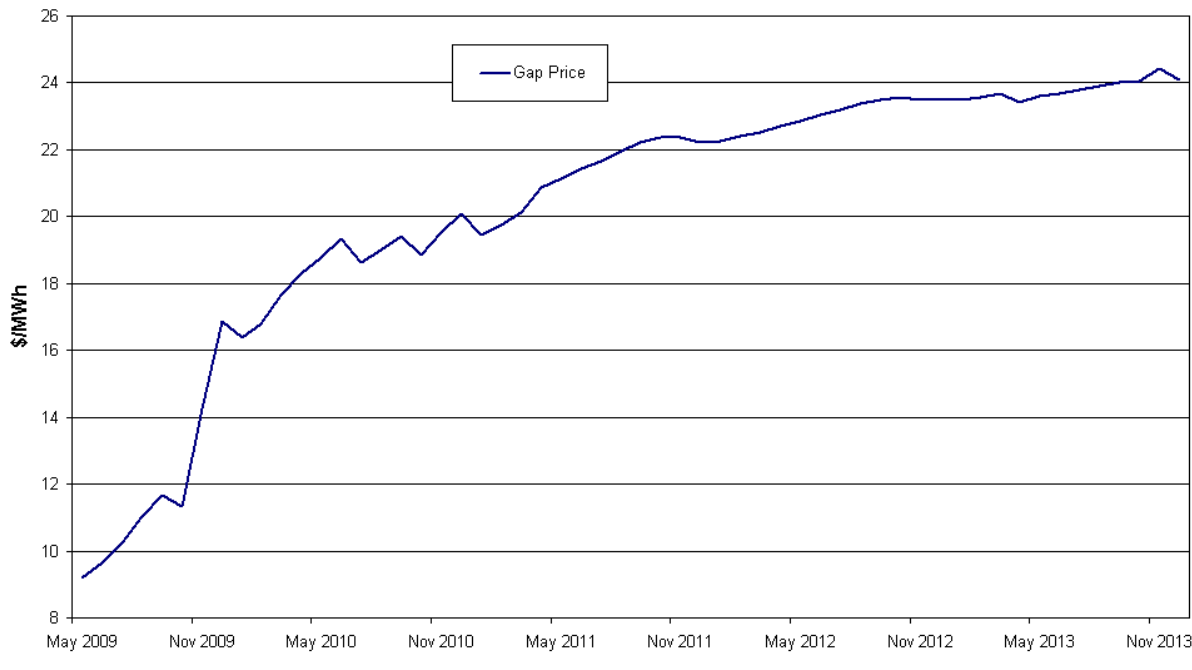
Figure 6. Fuel price gap as implied by futures prices of natural gas and